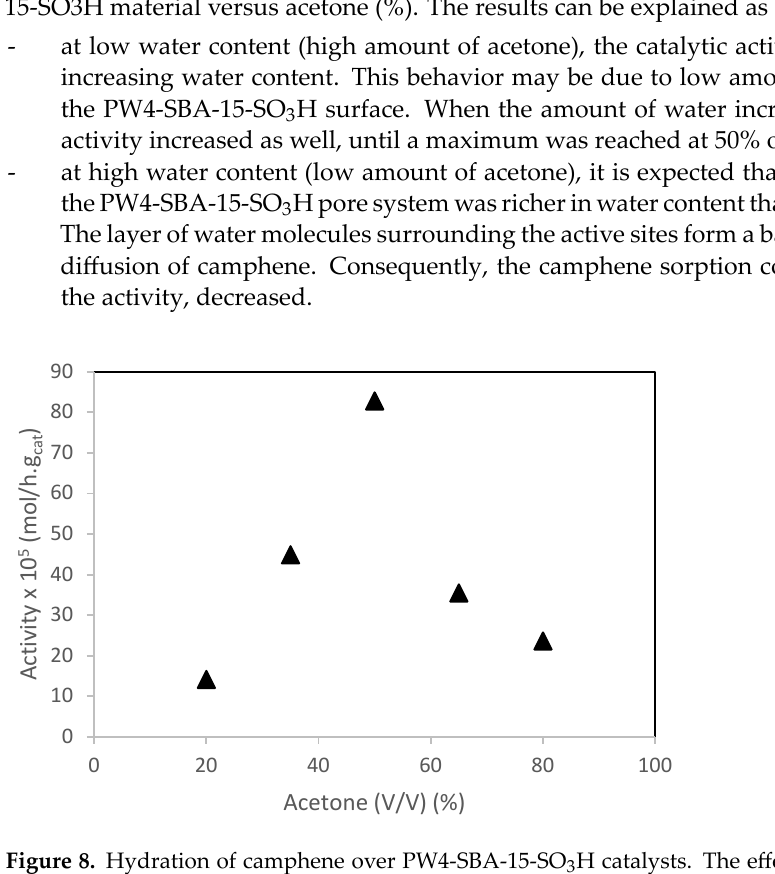
m cat = 0.482 g; V = 114 mL of aqueous acetone (1:1, V/V); n camphene = 7.5 mmol.